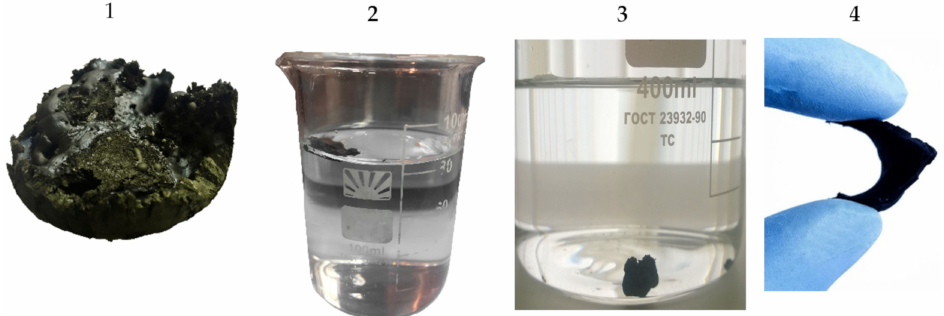
Figure 3. Pictures of aerogel samples obtained: 1 —light sample; 2 , 3 —before and after its hydrophilization; and 4 —denser sample.